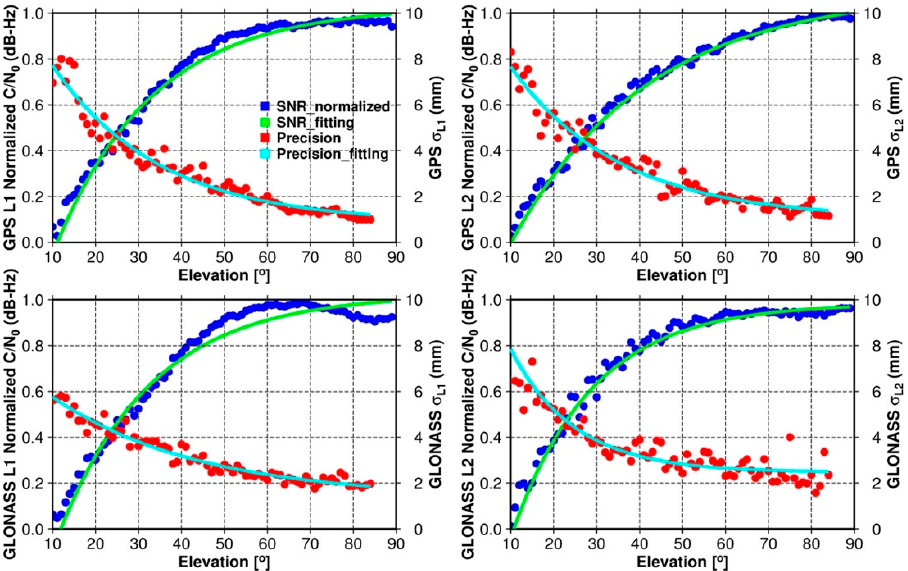
Figure 10. The estimated elevation-dependent precisions in Xi et al. and normalized SNR data, and their modelling with the exponential type predefined models.